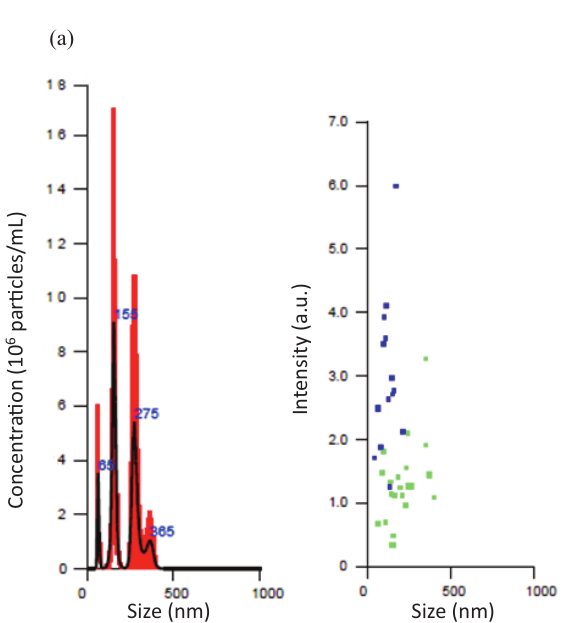
' Particle size (nm) and distribution at [SrS] = 0.836 ± 0.01 mM (pH = 11.07 ± 0.02); the average concentration of particles is 1.64 ± 0.71·10 7 per mL.